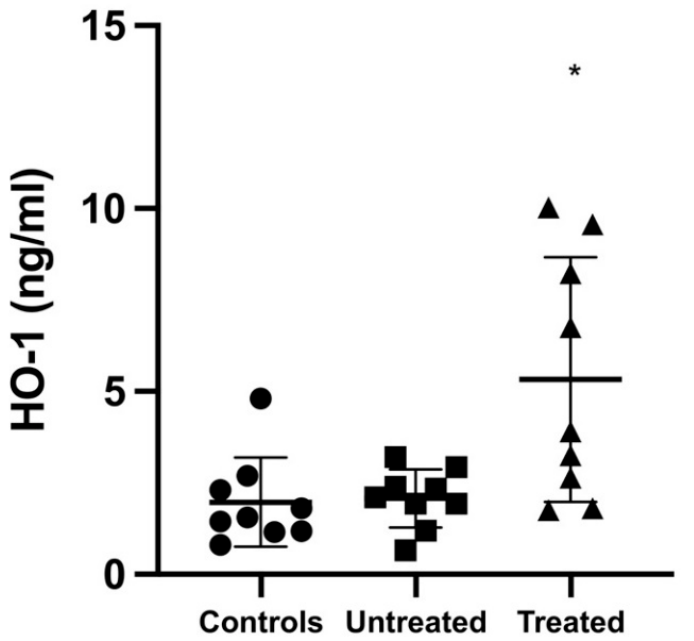
Figure 3. HO-1 protein expression. The HO-1 protein concentration was significantly higher in ADPKD patients treated with tolvaptan compared to that in both untreated ADPKD patients and controls (*: p = 0.012). Data are expressed as mean ± SD.